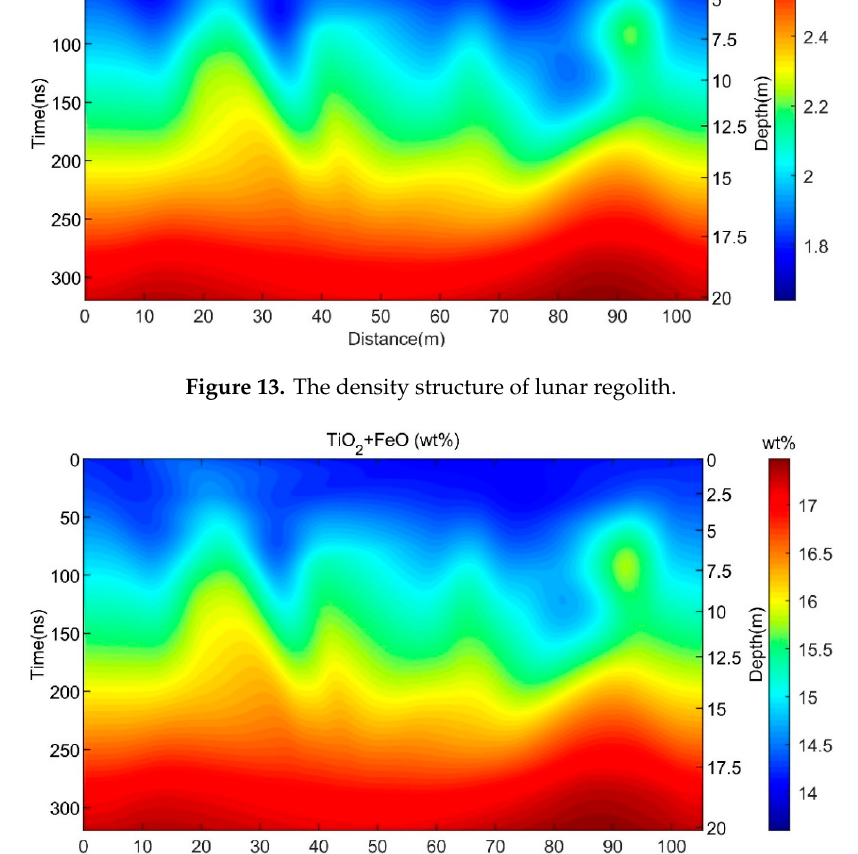
Figure 14. The TiO 2 and FeO content of lunar regolith.